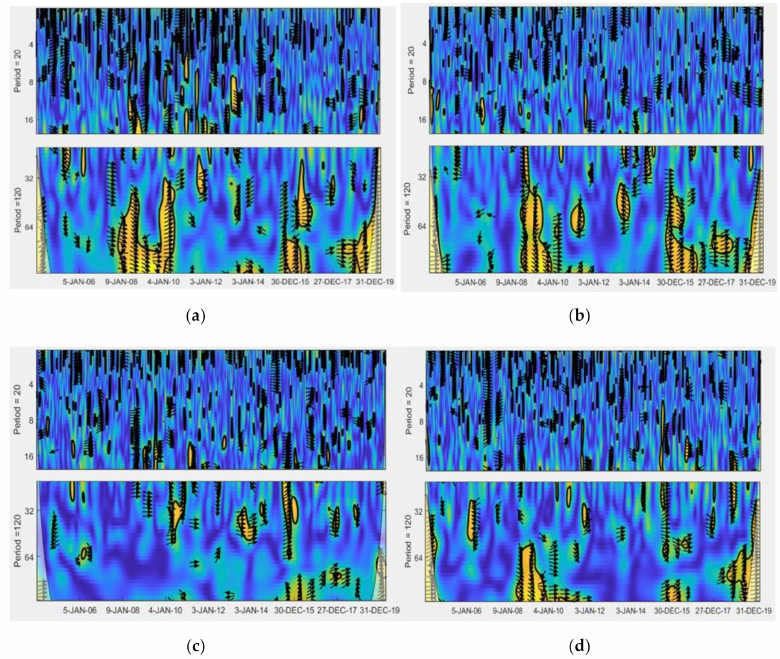
Figure A2. Long-term and short-term wavelet coherence diagrams of WTI crude oil price fluctuation and stock markets: ( a ) US stock market, SP500; ( b ) Japanese stock market, N225; ( c ) mainland China’s stock market, SSEC; ( d ) Hong Kong stock market,